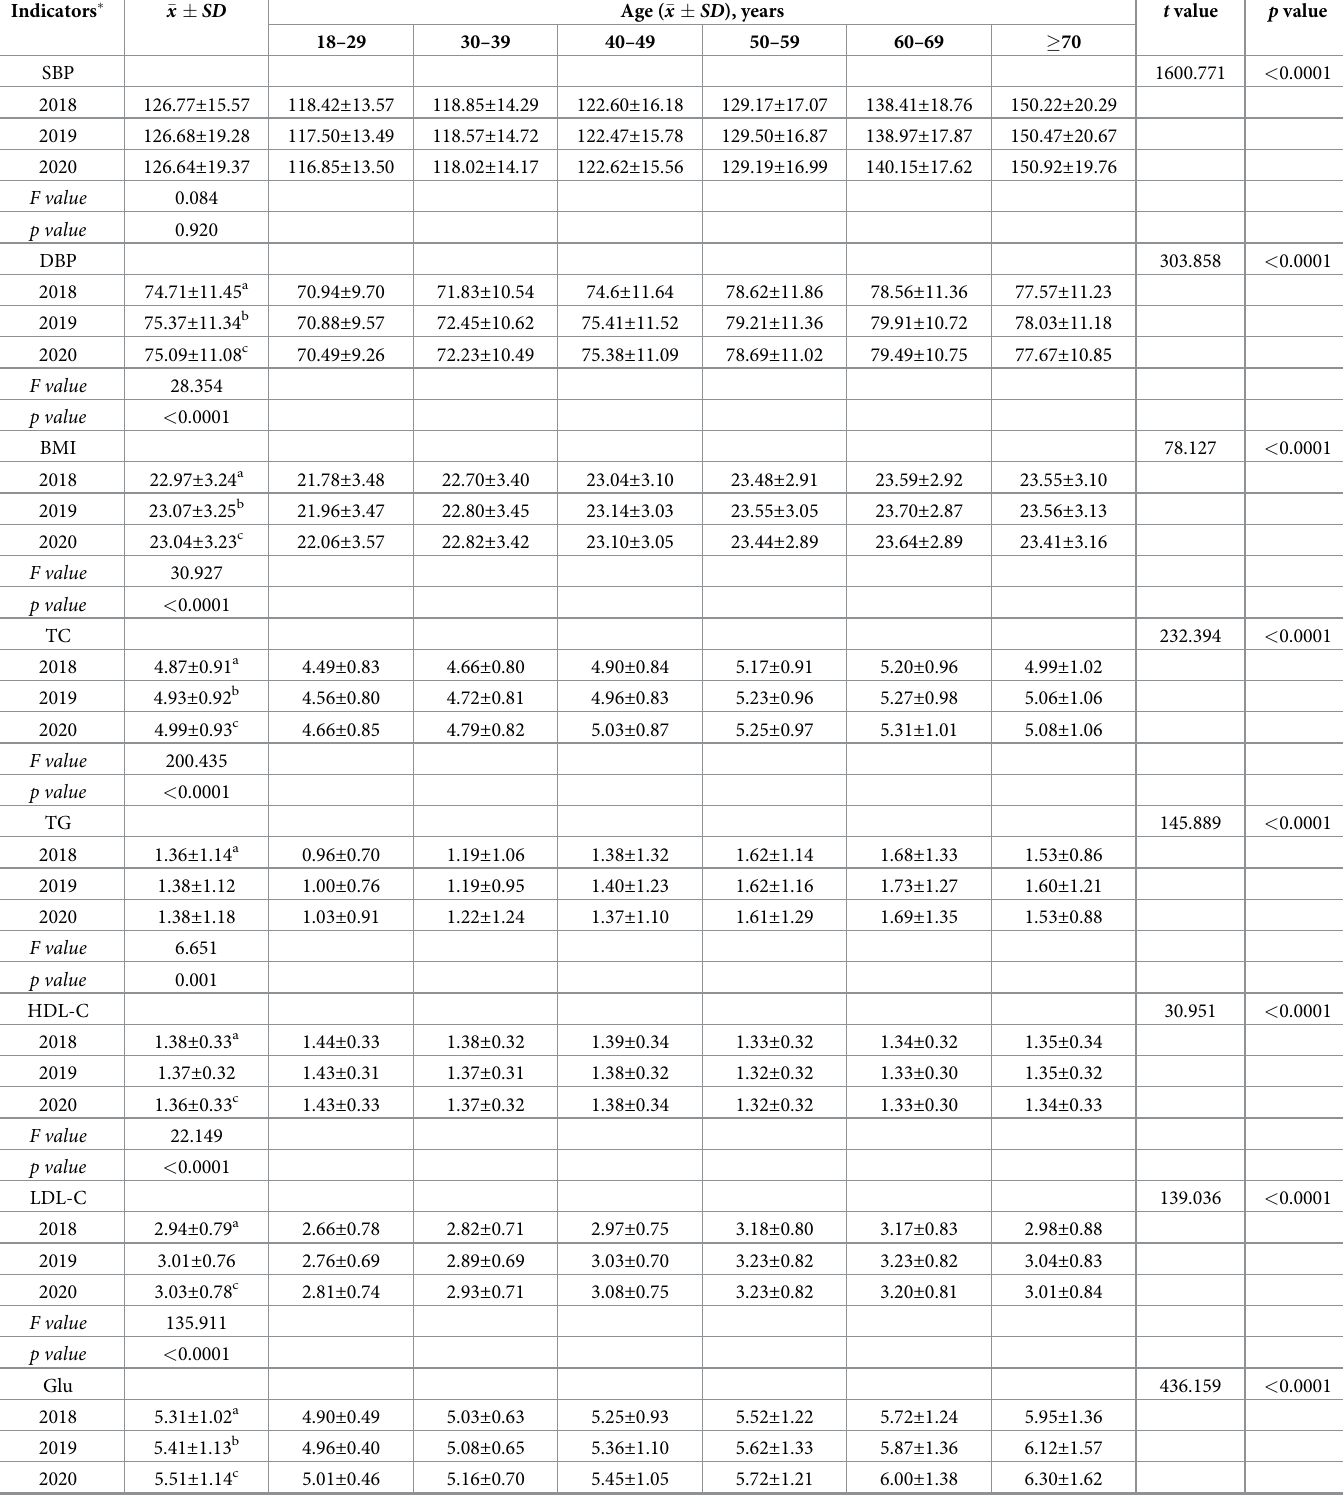
Table 4. Characteristics of cardiovascular health indicators of participants in different age groups. Indicators